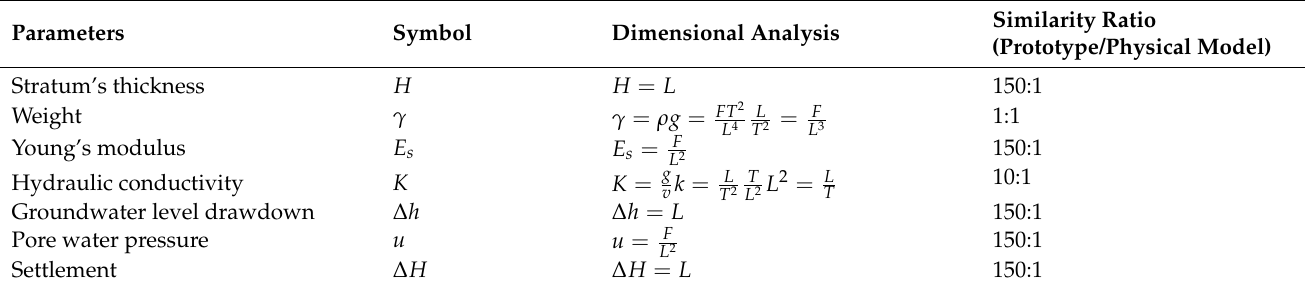
Table 2. Dimensional analysis of main parameters in physical model